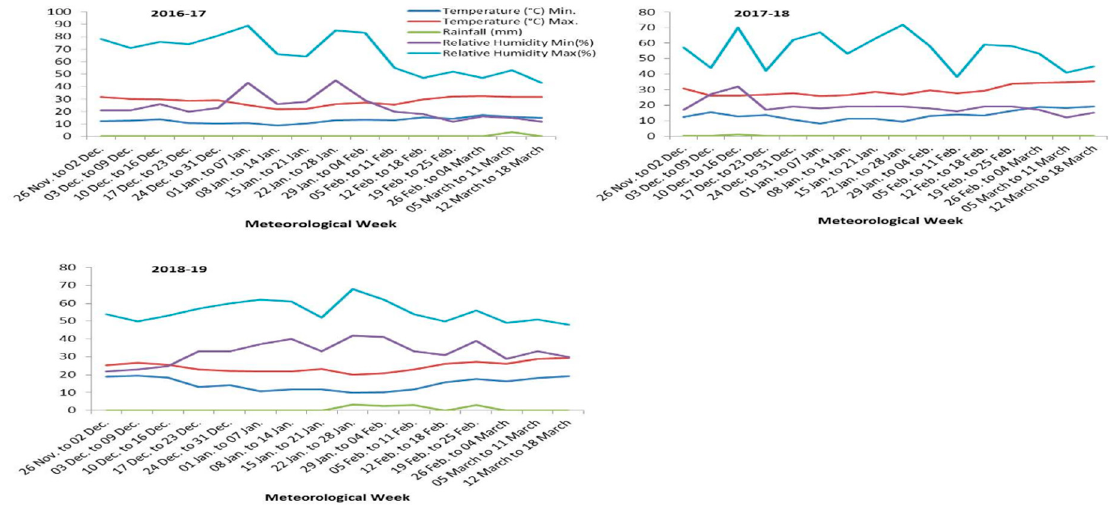
Figure 1. Weather parameters during the crop-growing period.